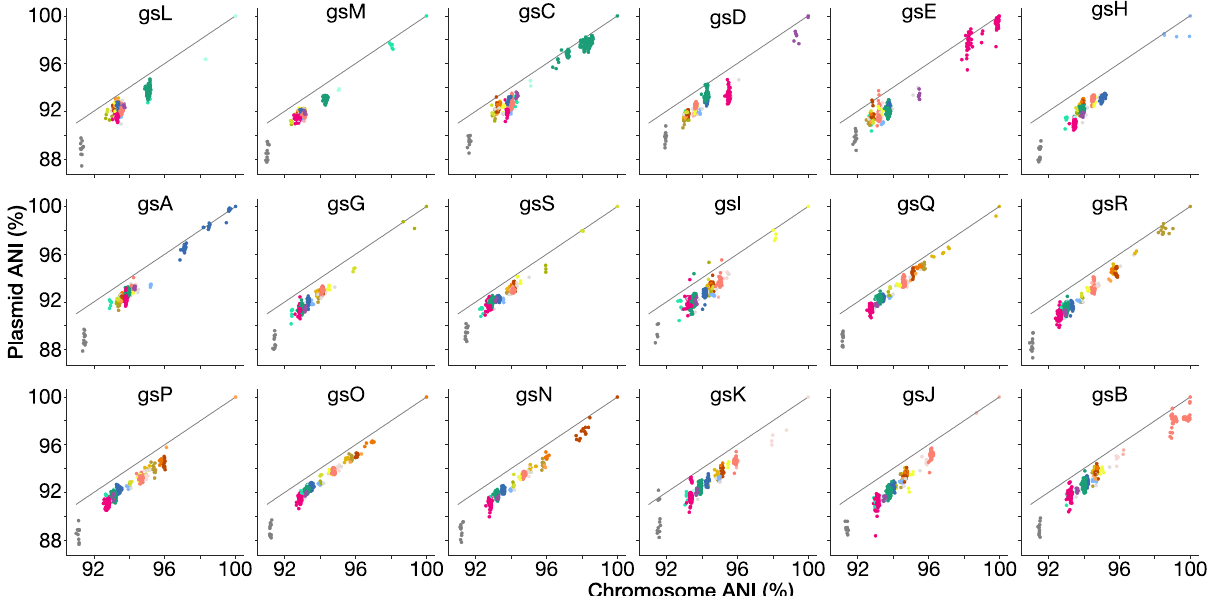
Figure 7. ANI of plasmid and chromosome genome compartments. The plasmid compartment includes chromids. Each point represents the values for the two compartments in a single pairwise comparison between genomes. Each panel shows values for every strain (colored by genospecies) compared to the representative strain for the indicated genospecies.